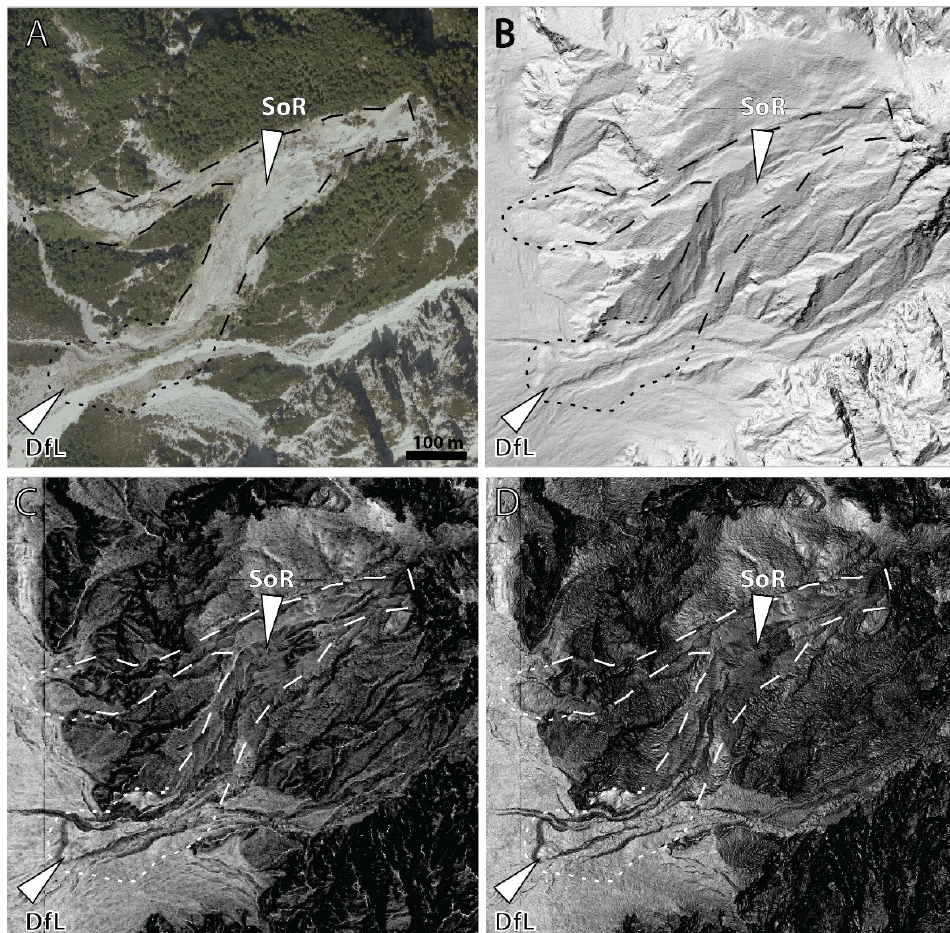
Figure 10. Debris flow deposits under the slopes of Mountain Ciprnik. Surface of rupture (SoR) and debris flow lobe (DfL) are marked with white arrows. ( A ) Aerial photography, ( B ) analytical hillshading (A315, H35), ( C ) 8-bit sky view factor and ( D ) 8-bit slope visualisations. For location see rectangle 10 in Figure 1.